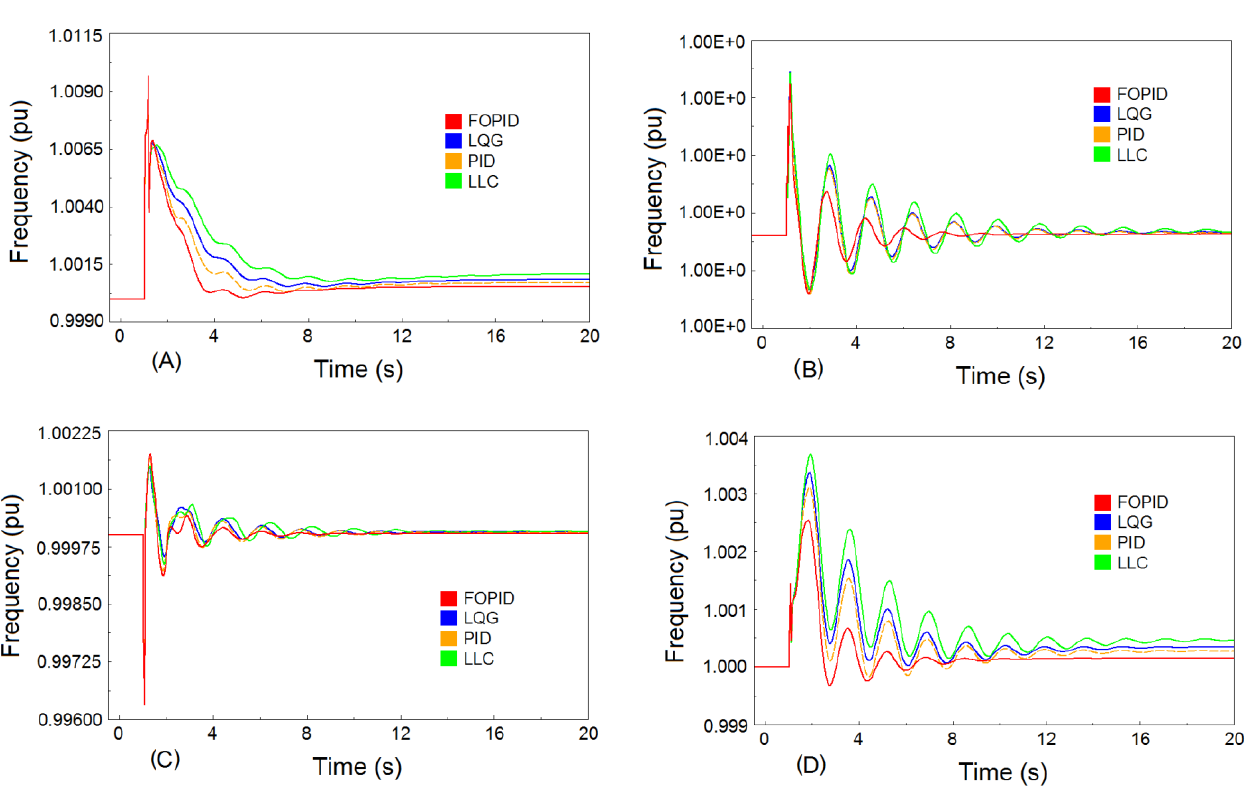
Figure 12. Power system frequency at bus 6 for scenario 1: ( A ) state 1, ( B ) state 2, ( C ) state 3, and ( D ) state 4.